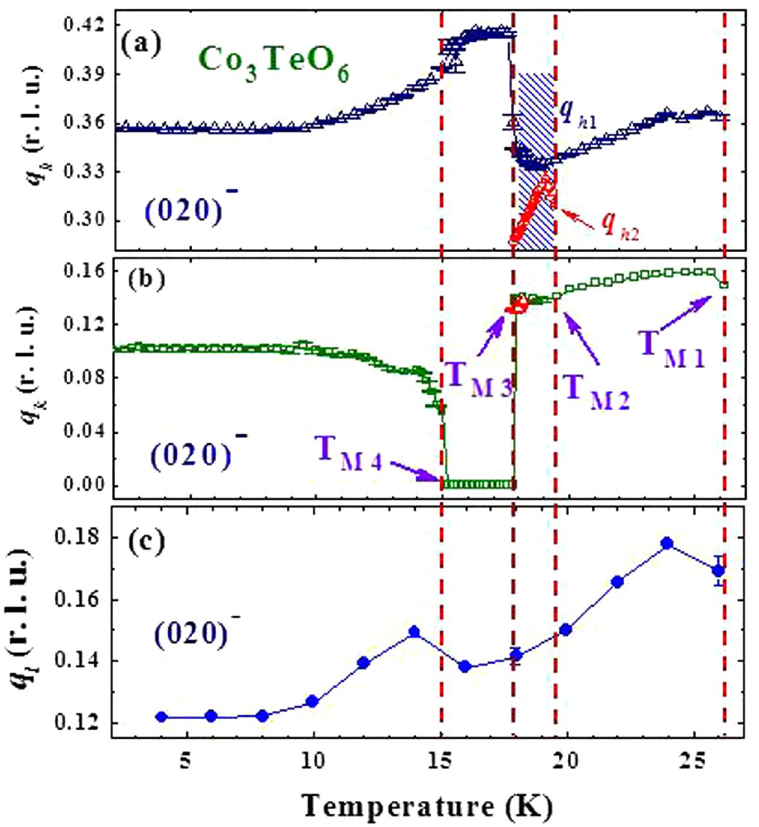
Figure 11. Thermal variations of ( a ) q h ( b ) q k and ( c ) q l of the (020) − satellite reflection, revealing all three components of the modulation vector change with temperature. The modulation vector stabilizes below 10 K, where the second-order satellite intensities become fully developed. There are two sets of q h , marked q h1 and q h2 , which appear between 18 and 19.5 K. The dashed vertical lines indicate the temperatures at which the transitions are observed in Co 3 TeO 6